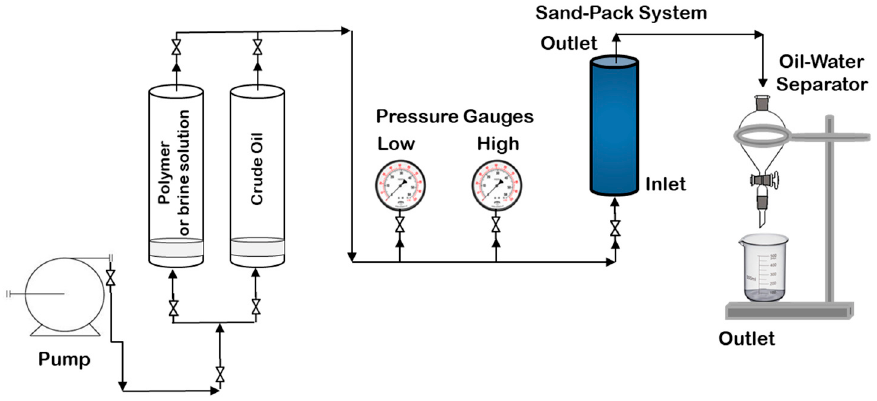
Figure 8. Experimental sand-pack system set-up for the evaluation of polymer flooding.